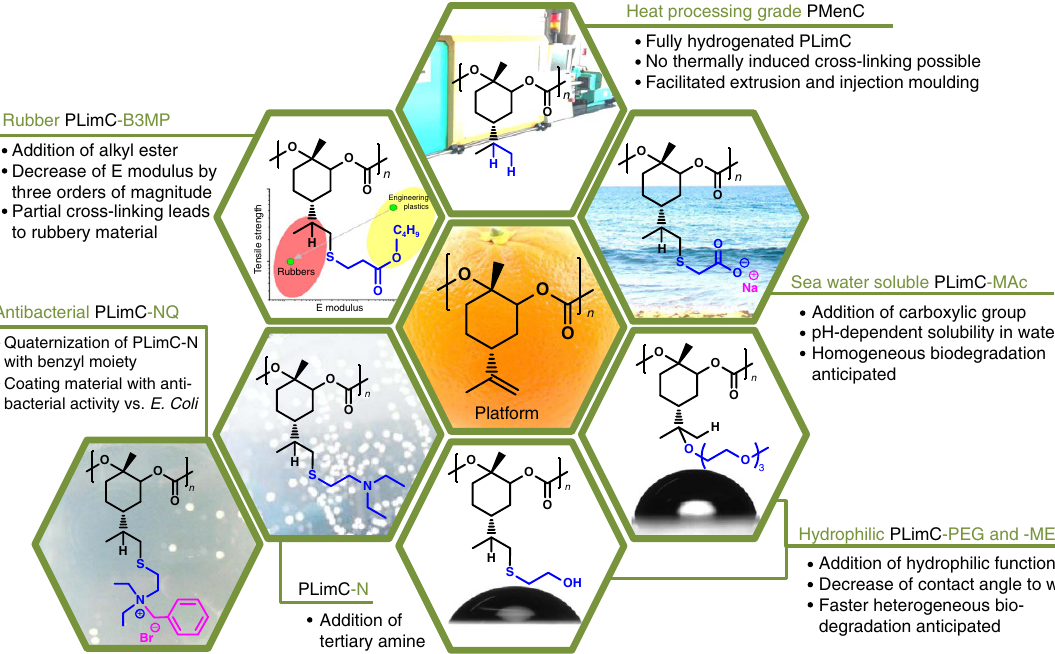
Figure 2 | The valorization of PLimC. The versatility of the platform polymer PLimC is illustrated in this hexagon cluster. The double bond is used for addition reactions, to induce dramatic changes of the properties of PLimC. The addition of an alkyl ester (PLimC-B3MP) leads to a drop of T g by 120 (cid:2) C and of its Young’s modulus by three orders of magnitude to give a PLimC rubber. The addition of a carboxylic group (PLimC-MAc) yields a pH-dependent solubility in water, whereas the functionalization with hydroxyl (PLimC-ME) or polyethylene glycol (PLimC-PEG) groups results in a higher hydrophilicity. The attachment of a tertiary amine (PLimC-N) and subsequent quaternization with an aromatic moiety (PLimC-NQ) leads to antibacterial activity against E. coli . Another possibility is the complete hydrogenation of the double bond to give PMenC, a superior material for heat processing.